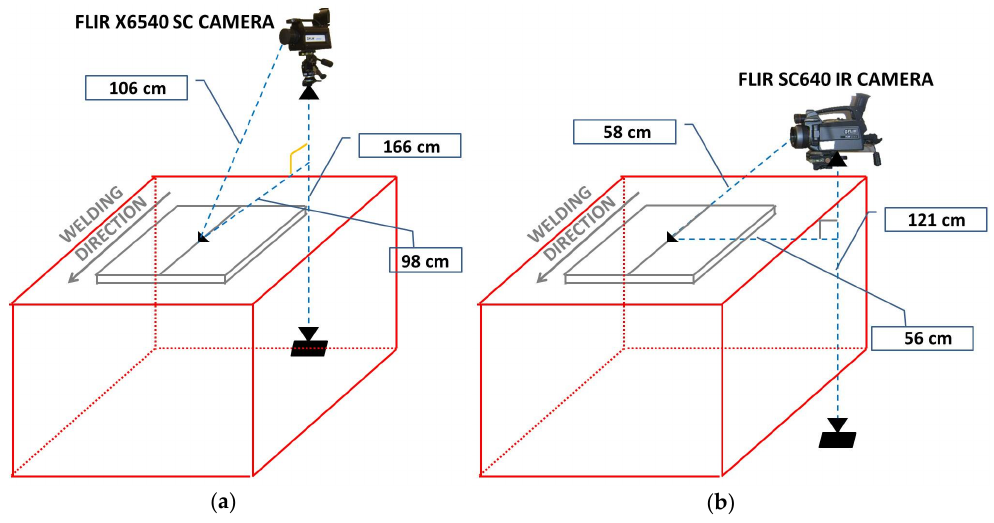
Figure 5. Set ‐ up used for thermographic data acquisition: ( a ) FLIR X6540 sc IR camera placed along the welding tool direction; and ( b ) Flir sc 640 IR camera placed perpendicular to the welding tool direction.